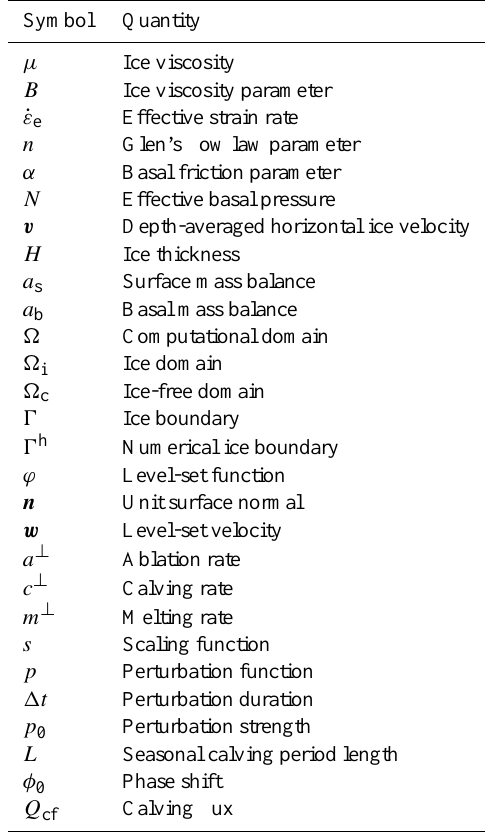
Table 1. Symbols and model